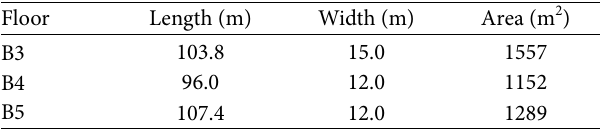
Table 1: Dimensions of the Lianglukou station.